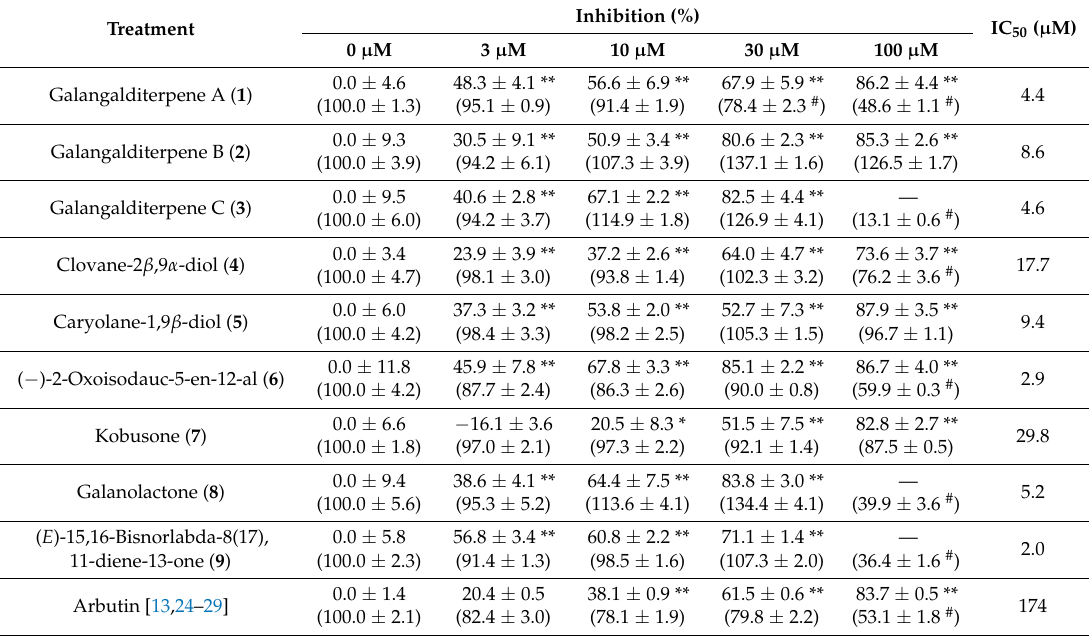
Table 2. Inhibitory effects of the isolates ( 1 – 9 ) from the fruit of A. galanga on theophylline-stimulated melanogenesis and viability in B16 4A5